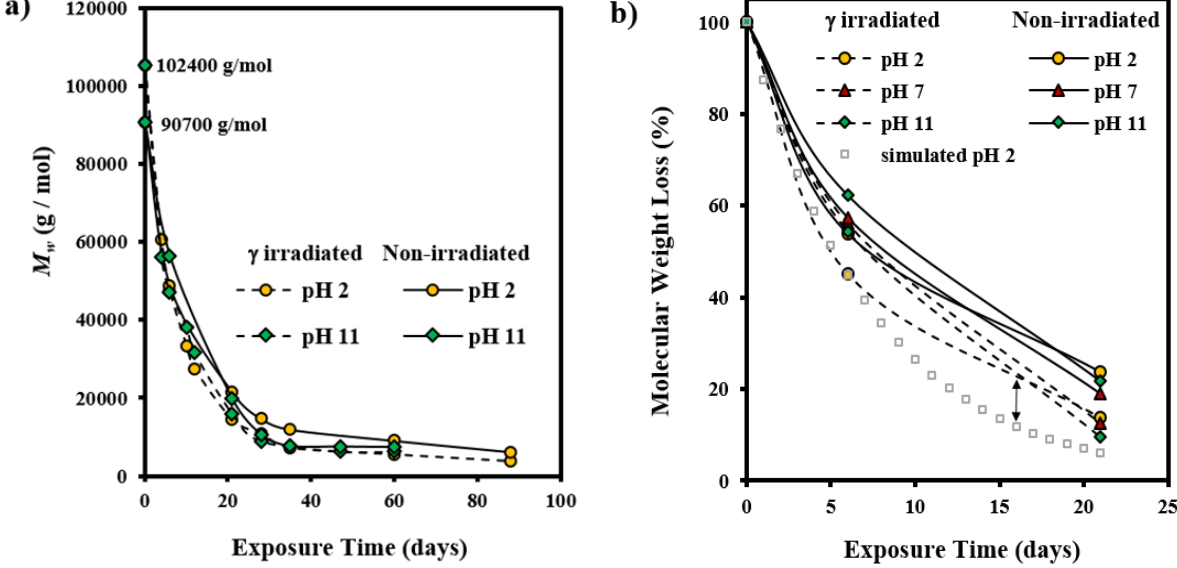
Figure 5. ( a ) Plots of the variation in the weight average molecular weight of a non-irradiated and a γ irradiated GL- b -[GL- co -TMC- co -CL]- b -GL sample during exposure to a pH 12 and pH 2 degradation media; ( b ) Plots of the variation in the weight average molecular weight (percentage) of a non-irradiated and a γ irradiated GL- b -[GL- co -TMC- co -CL]- b -GL sample during the first steps of exposure to representative degradation media. For the sake of completeness simulated data for a degradation following a first order equation is also drawn (dashed line) for the γ irradiated sample exposed to pH